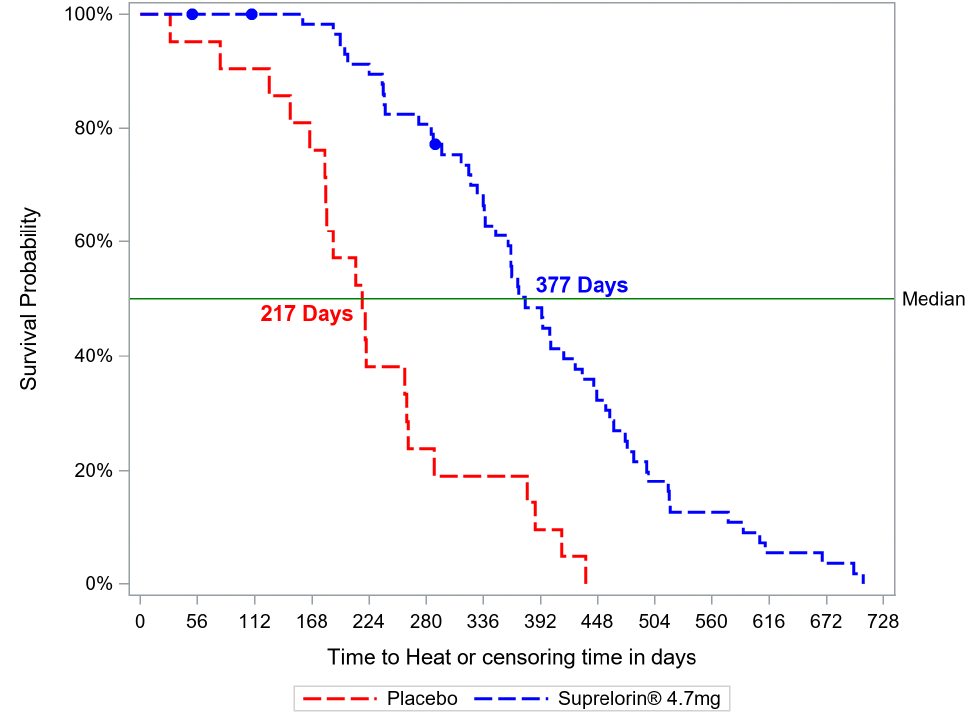
Figure 1. Time to heat occurrence in days over time, showing a significantly lower median in the placebo (red) than in the deslorelin (blue) group ( p < 0.0001, 217 days vs. 377 days respectively).